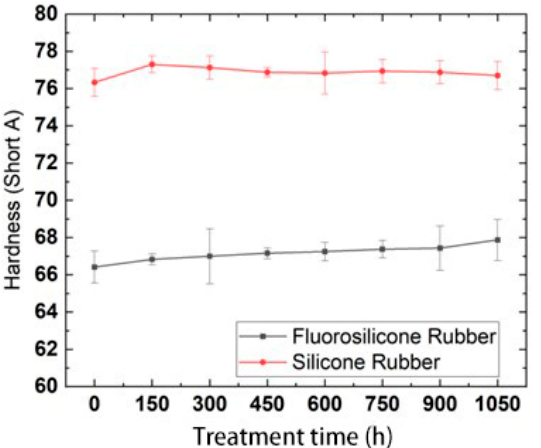
Figure 9. Hardness changes with low temperature freezing time.